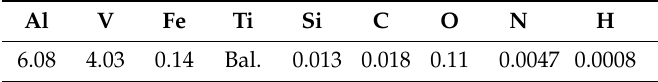
Table 1. Chemical composition of ELI grade Ti-6Al-4V alloy (wt. %).